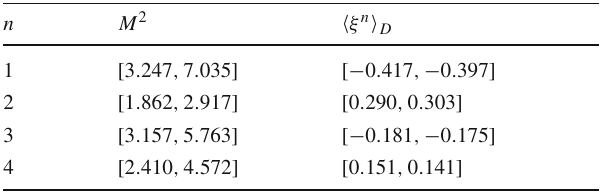
Table 2 The determined Borel windows and the corresponding D - meson leading-twist DA moments (cid:3) ξ n (cid:4) D ( n = 1 , 2 , 3 , 4 ) . All input parameters are set to be their central values